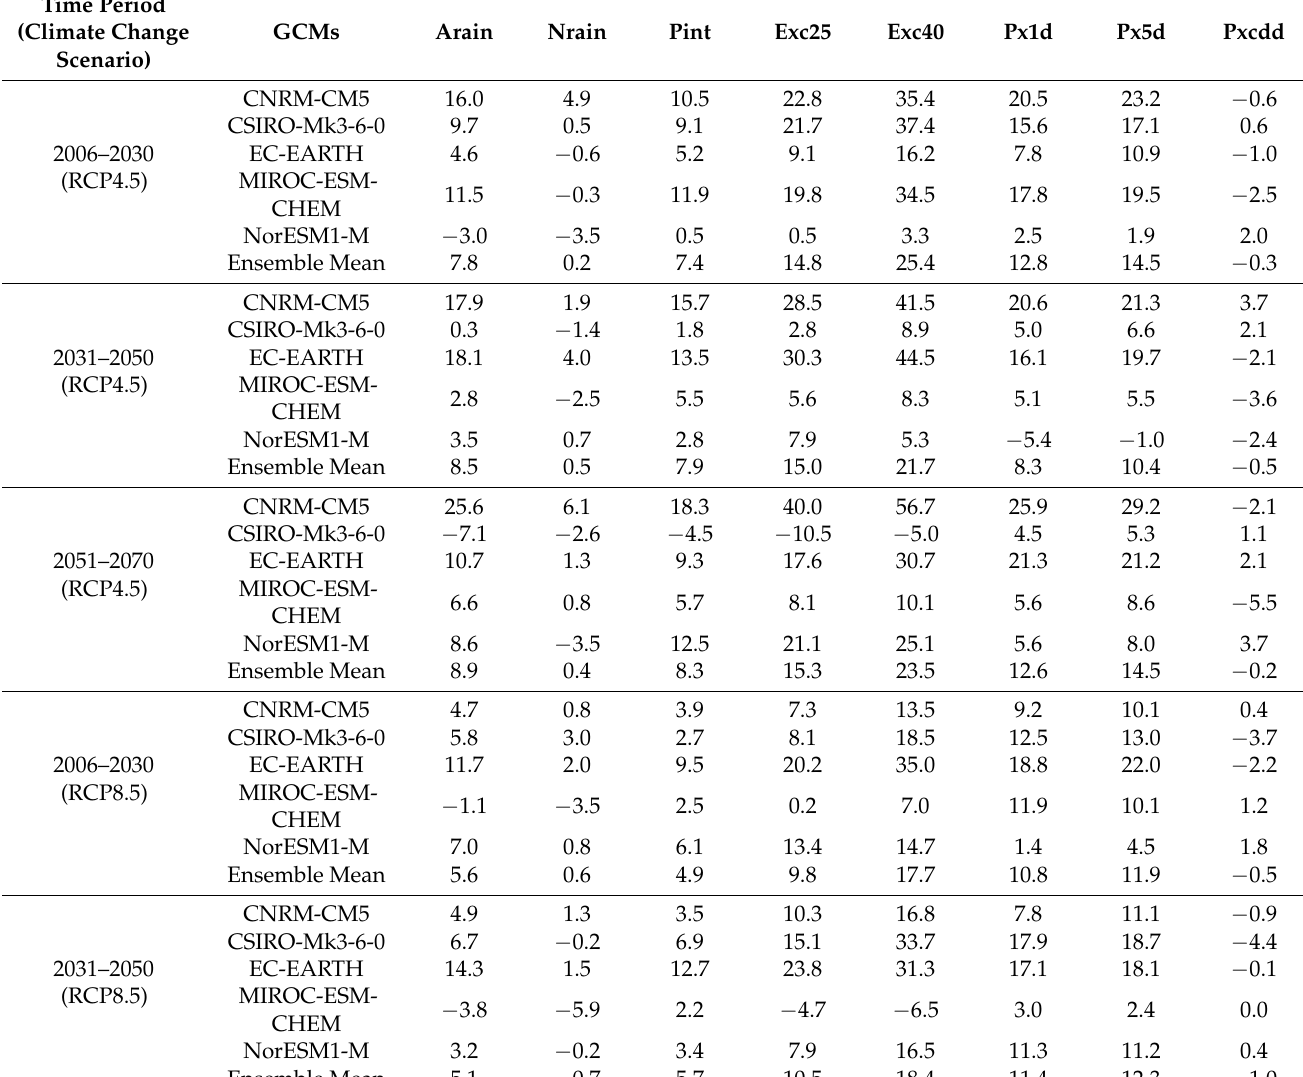
Table 3. Regional average percentage changes in the eight precipitation indices (unit: %), relative to 1961–2005, in the Beijing-Tianjin-Hebei region during the future three periods. These changes were calculated by downscaling from the five GCMs under RCP4.5 and RCP8.5 climate change